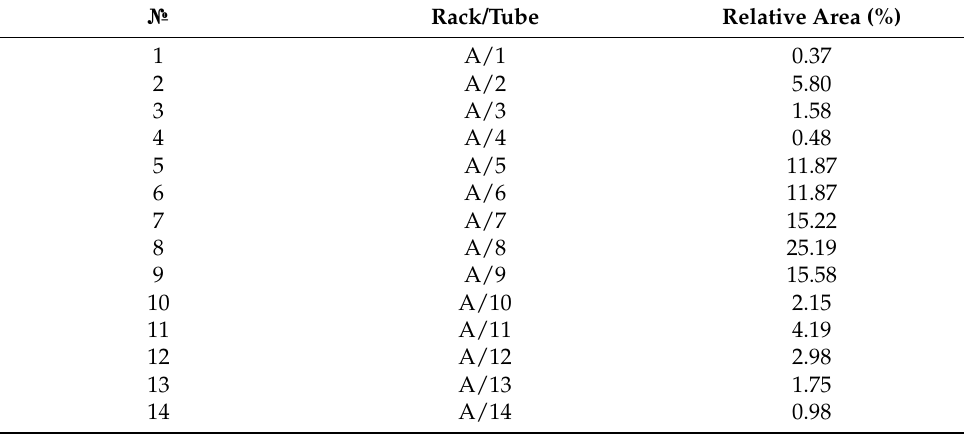
Table 3. Results of identification of metabolites produced by selected microorganisms. № Rack/Tube Relative Area (%) 1 A/1 0.37 2